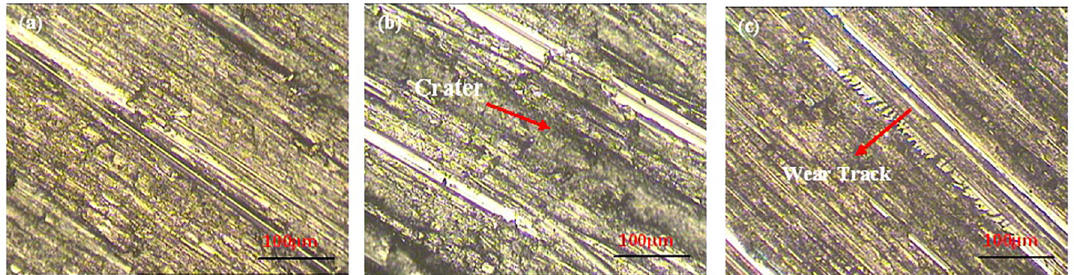
and Fe-1C-4W-1Ti is low due to contact of oxide layers and steel disc material. As the sliding distance increases